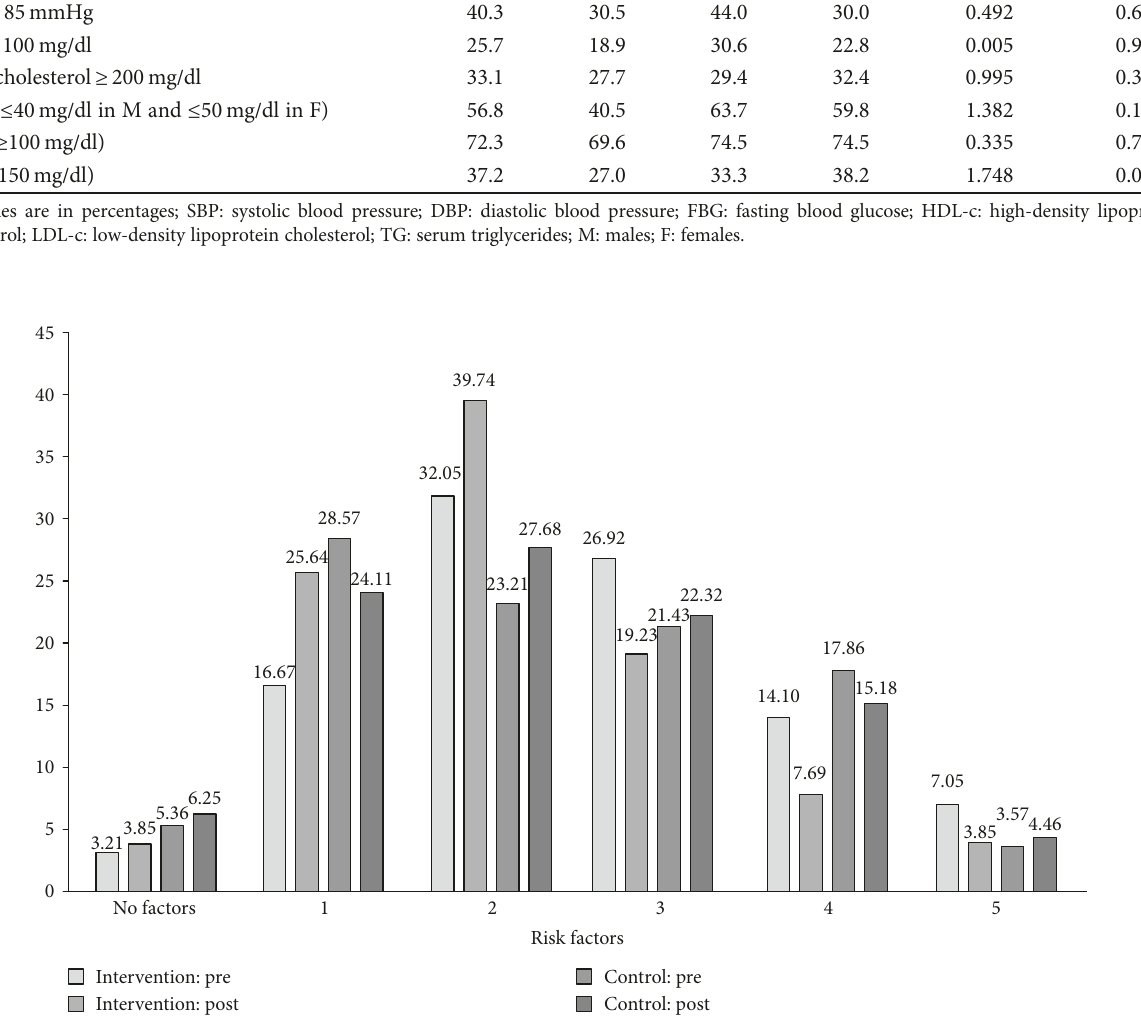
Figure 3: Changes in clustering of risk factors comprising metabolic syndrome before and after intervention. All the values are in the percentage. Please see text for de fi nitions of risk